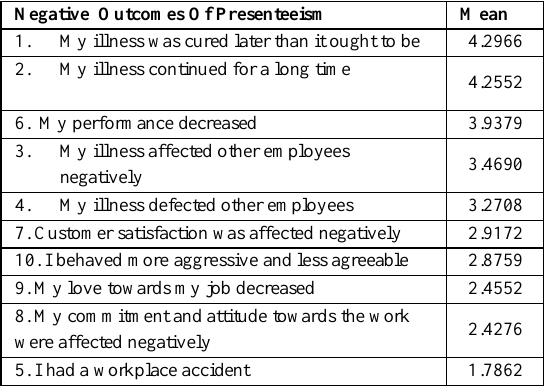
Table 11: Negative Outcomes of Presenteeism and Their